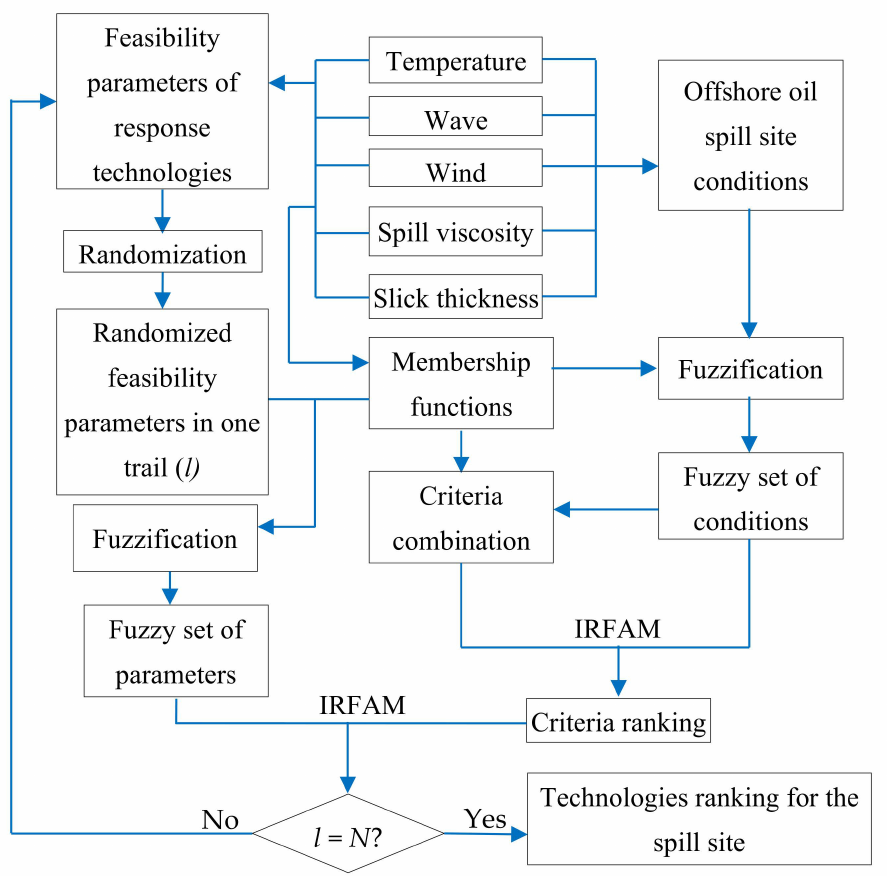
Figure 3. Framework of the MC-IRFAM